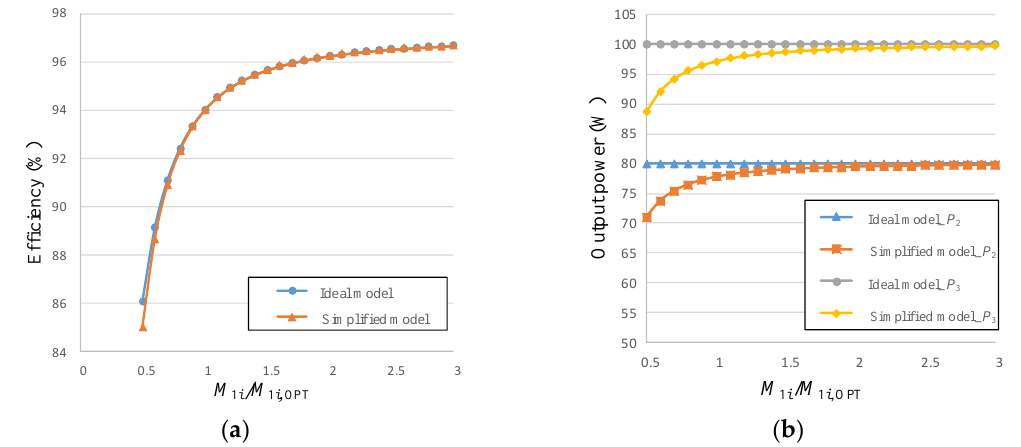
Figure 12. Efficiency of simplified model and ideal model versus mutual inductance ratio ( M 1i / M 1 i , OPT ): ( a ) efficiency results; ( b ) power results.